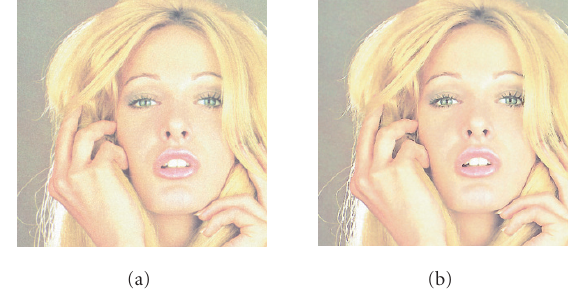
Figure 9: (a) Noisy 24-bit color image and (b) result of the applica- tion of the proposed